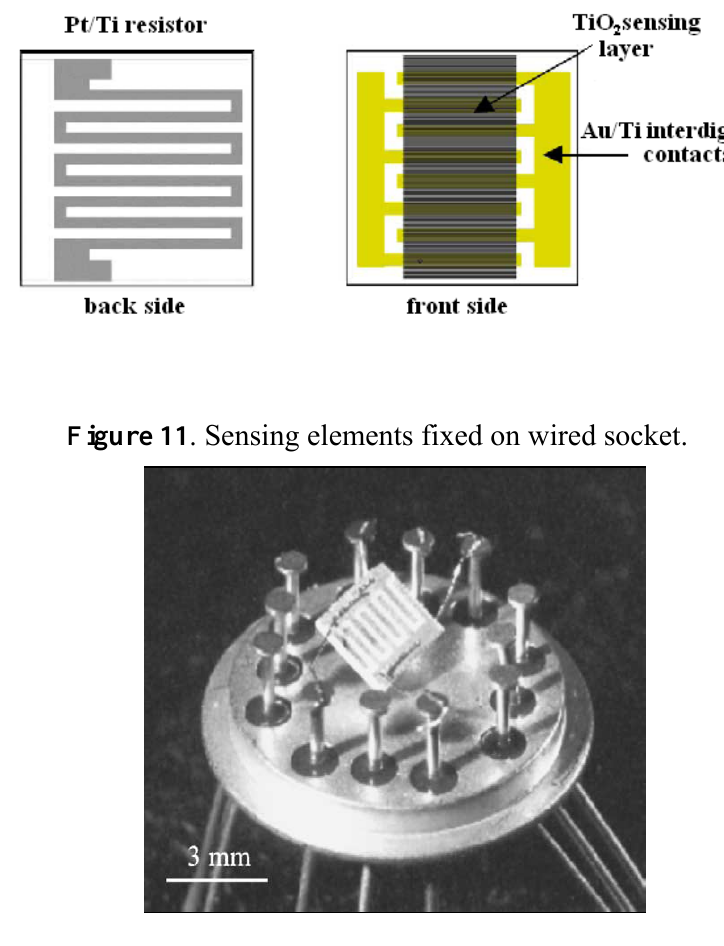
Figure 10 . Back and front side of the sensing element.